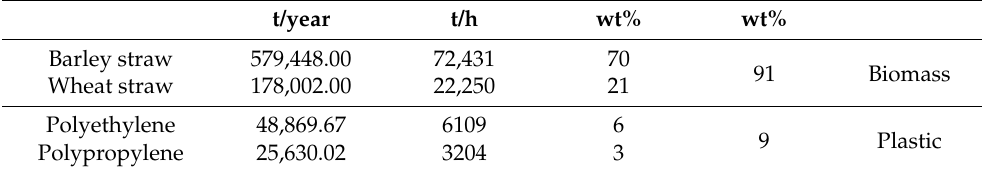
Table 1. Raw material summary